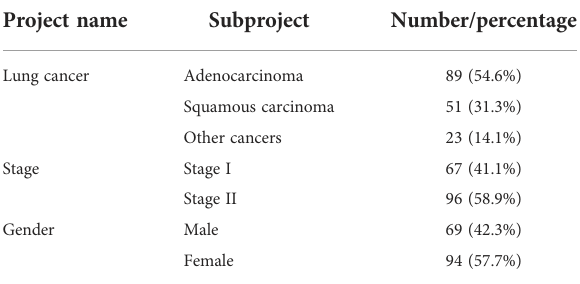
TABLE 3 Information on lung cancer samples in the test set.